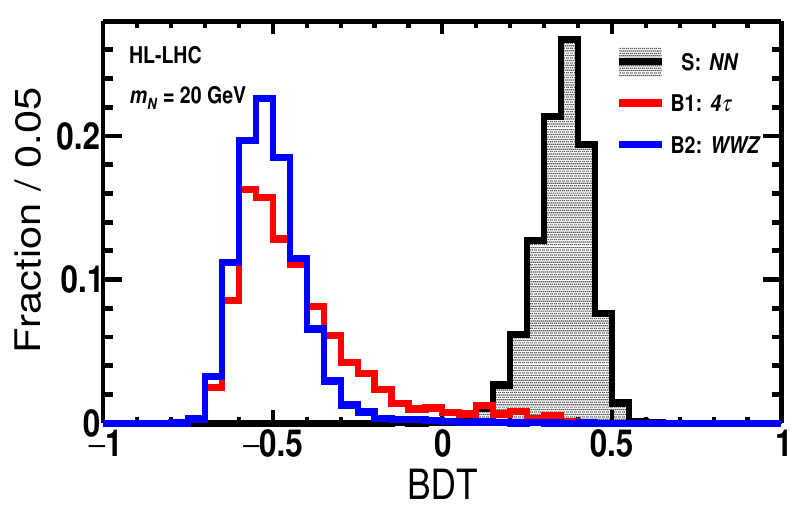
Figure 2 . Distributions of BDT responses for the signal event sample (black, (cid:12)lled), and those for the SM background samples including 4 (cid:28) (red) and WWZ (blue). This (cid:12)gure illustrates an h 1 decay signal by gluon fusion at the HL-LHC, with m N =20